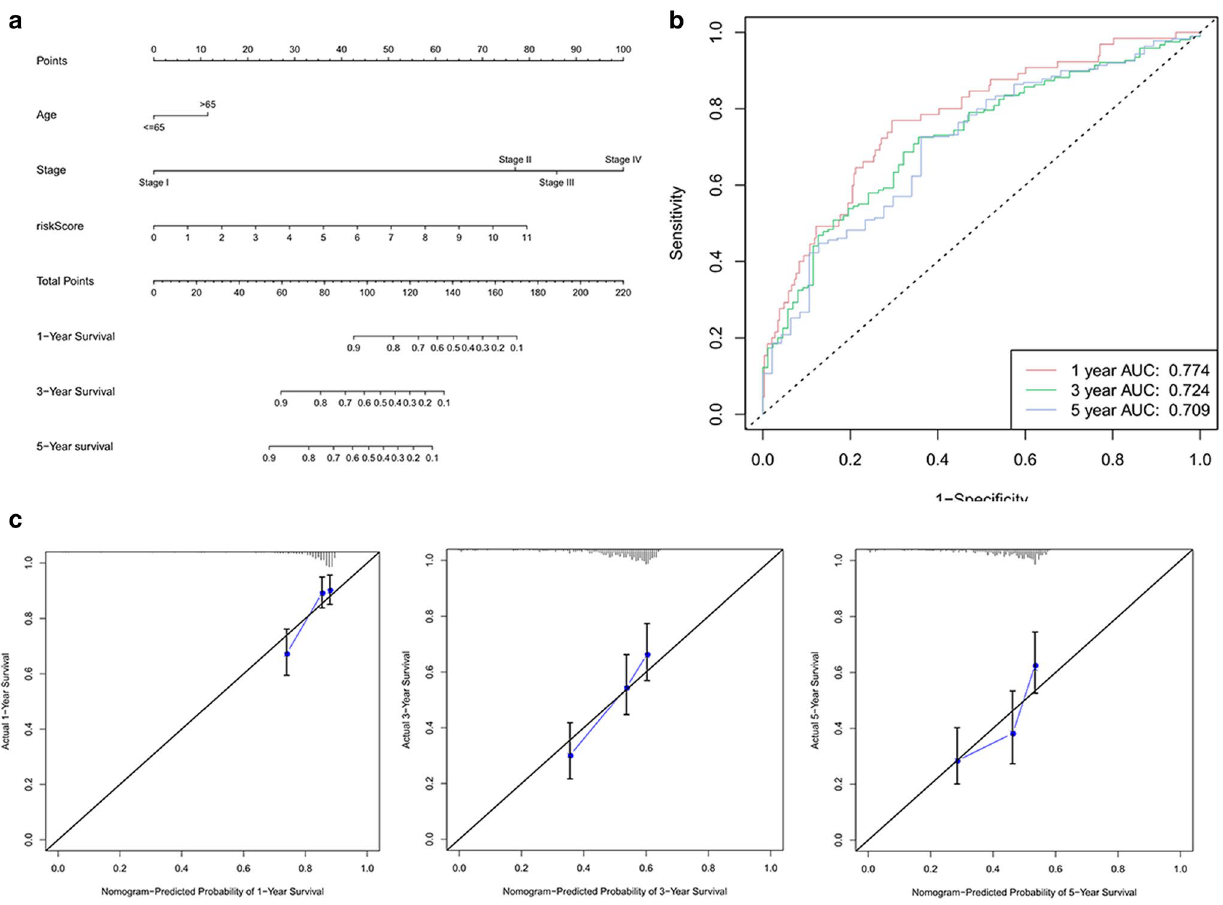
Figure 7. Building and evaluating the predictive power of the nomogram. ( a ) A nomogram constructed based on the five PIRMGs signature, age and stage. ( b ) Time-dependent ROC curves of the nomogram in the prediction of prognosis at 1-, 3-, and 5-year time points. ( c ) Calibration plots of the nomogram in 1-, 3-, and 5-year survival. The predicted and the actual probabilities of survival are plotted using blue and black solid lines,